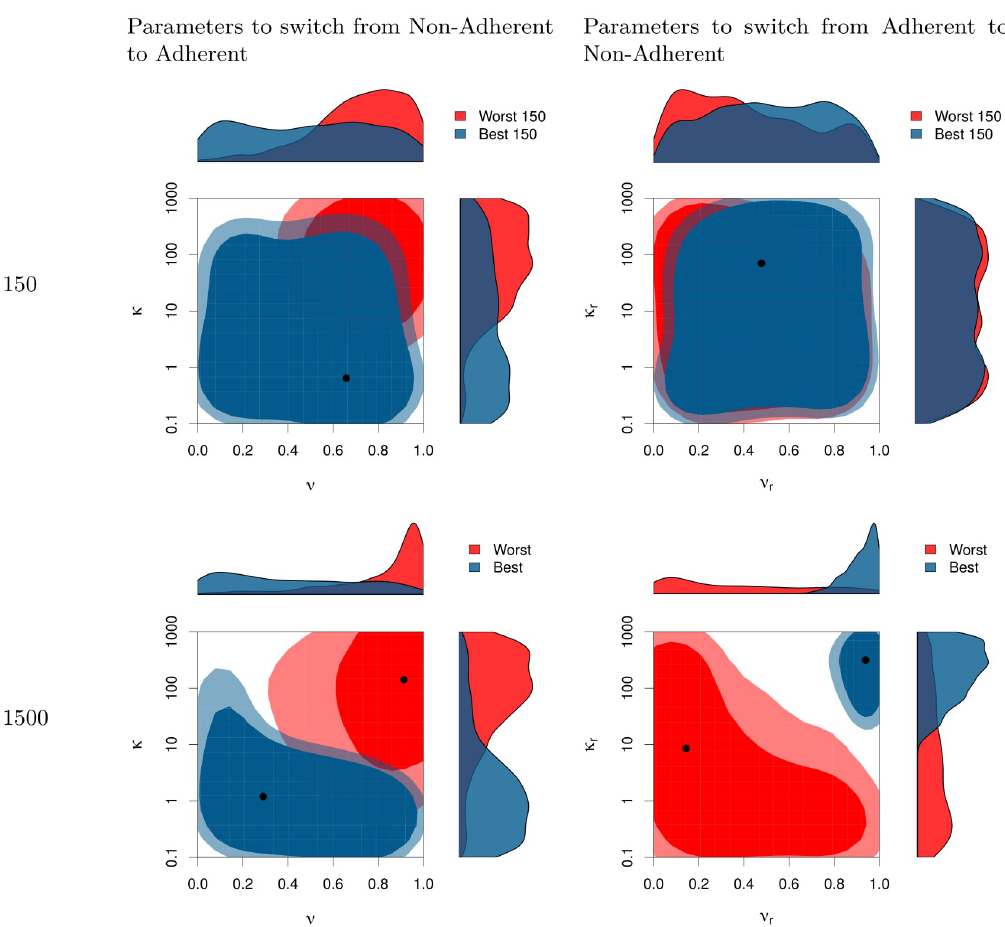
Fig 5. Joint posterior distributions for the parameters used to switch from Non-Adherent to Adherent (left column) and for the parameters used to switch back from Adherent to Non-Adherent (right column). The two-dimensional areas represent the 70% and 90% HDR (High Density Region) i.e ., the smallest areas within which respectively 70% and 90% of the parameters combination fall (for the mathematical definition of HDR and how they can be represented see [66]. Lighter colors represent the 90% HDR whereas darker represent the 70% HDR. The top row represents the value for those parameters that minimize (in blue) or maximize (in red) the number of infected people at time step 150. The bottom row shows the parameters that minimize (in blue) or maximize (in red) δ (as defined in Eq 3) at the end of the simulation (1500 time steps). Marginal posteriors for each parameter are drawn in the